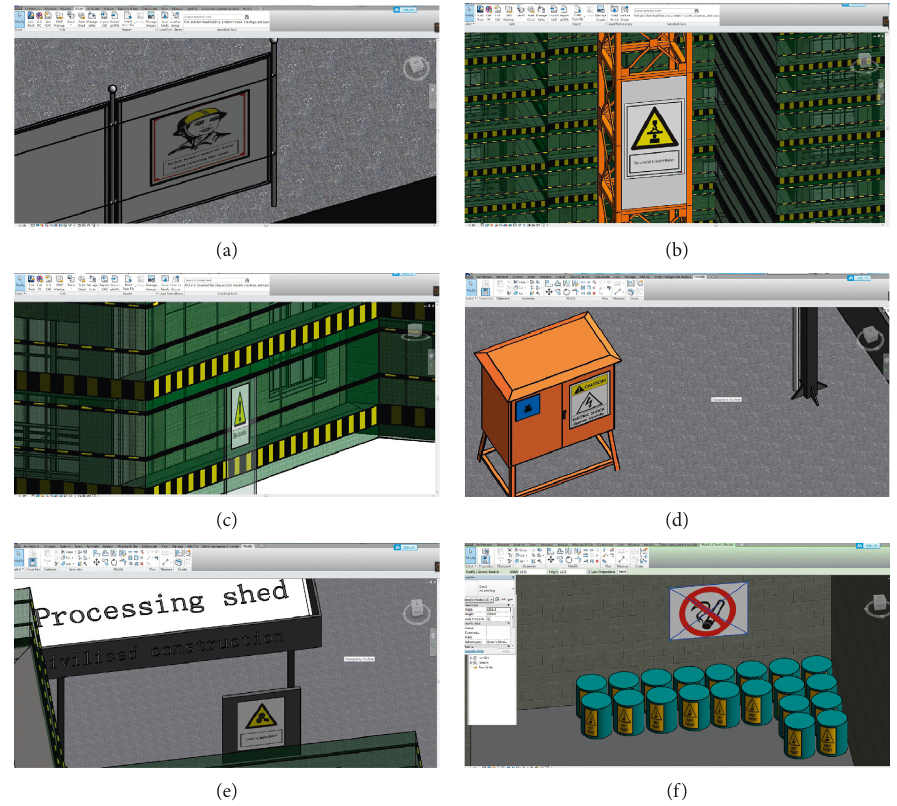
Figure 6: Schematic diagram of hazard source identification.